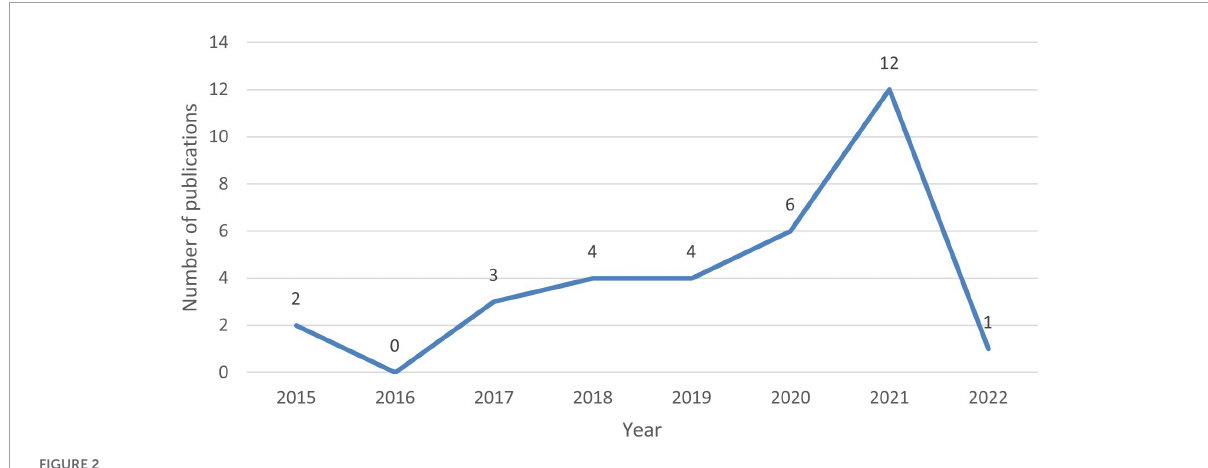
FIGURE2 Distribution of publications by year.